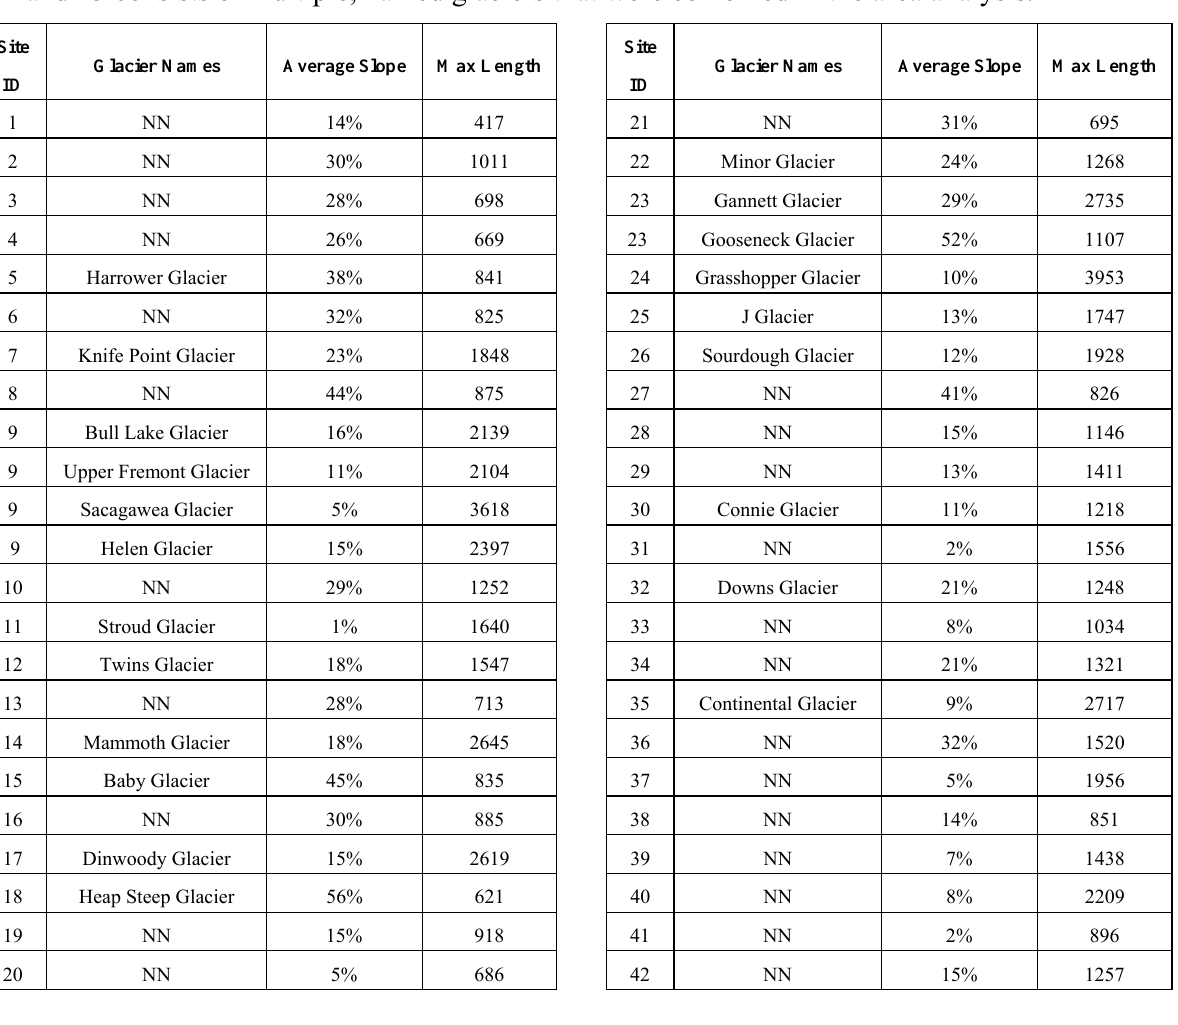
Table 1. Wind River Range glaciers [ID, name, average slope (%) and maximum length (m)] identified for current research (NN denotes and unnamed glacier). Site ID 9 and 23 consists of multiple, named glaciers that were combined in the area